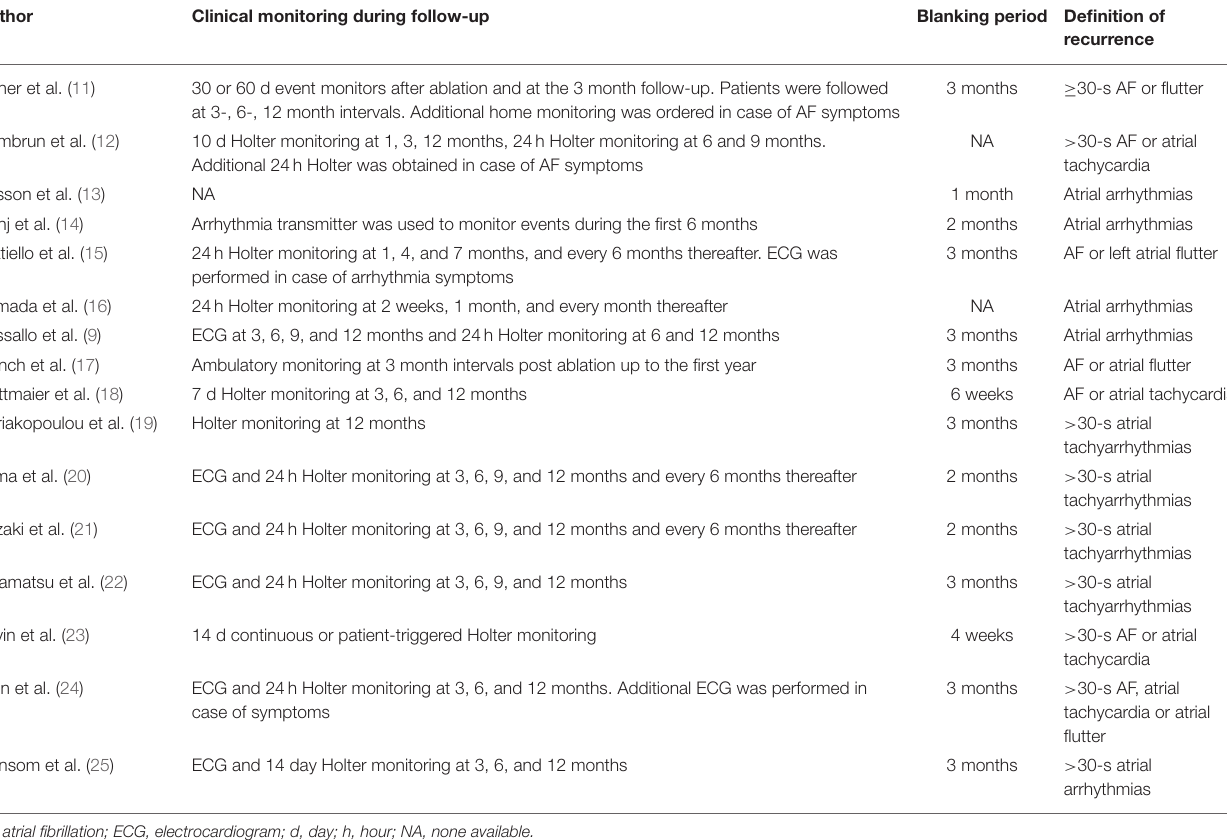
TABLE 2 | Detailed clinical follow-up information of included studies.